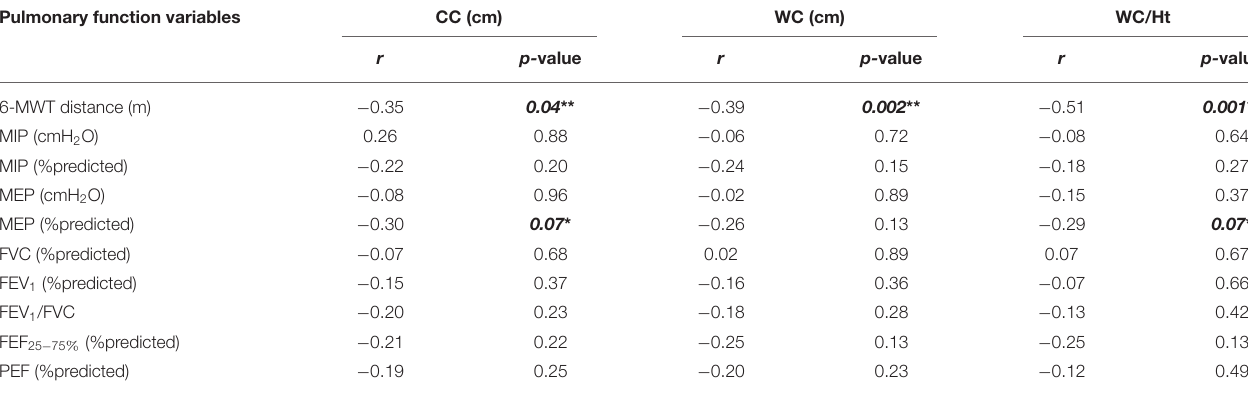
TABLE 4 | Correlation between obesity indices (CC, WC, and WC/Ht) and 6-MWT distance, RMS, and spirometry in the obesity group. Pulmonary function